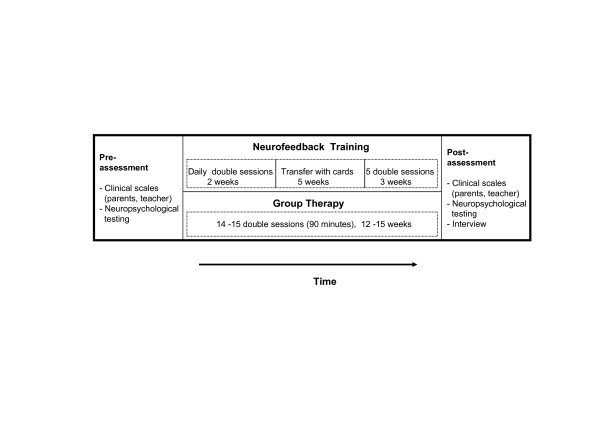
Design of the study